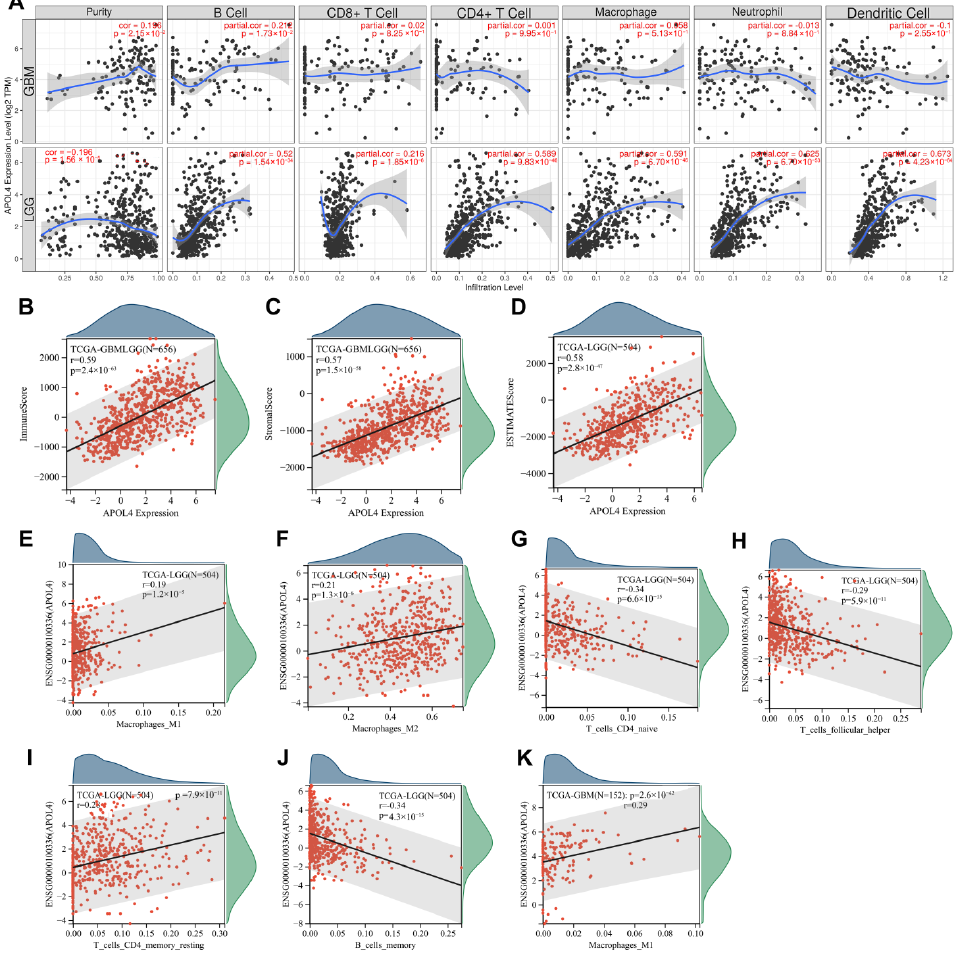
Figure 4. The connection between APOL4 and TIIC infiltration. ( A ) The relationship of APOL4 with TIIC infiltration in the TIMER database. The correlation between APOL4 and the immune ( B ), stromal ( C ), and ESTIMATE scores ( D ). The correlation of APOL4 with the infiltration of macrophages M1 ( E ), M2 ( F ), naïve CD4+ T cells ( G ), T cells follicular helper ( H ), T cells CD memory resting ( I ), and B cell memory ( J ) in LGG. ( K ) The relationship of APOL4 with the infiltration of macrophage M1 in GBM.